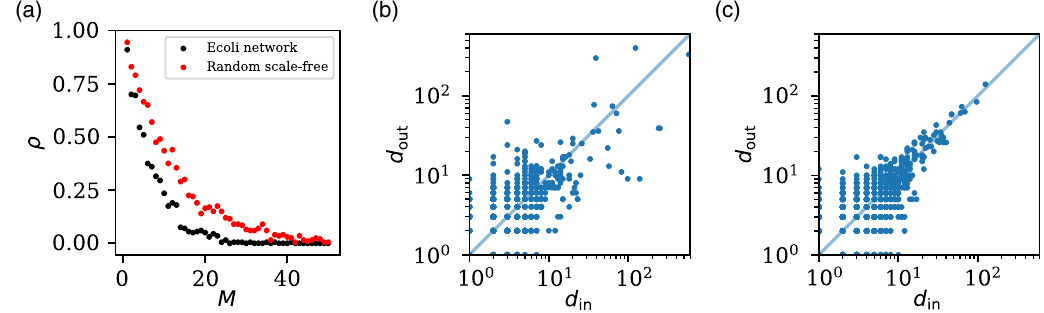
FIG. 7. Effect of the degree distribution on invertibility under the uniform random scheme. (a) The fraction of structural invertible input-output configurations for the E. coli metabolic network (black dots) is compared to an ensemble of scale-free random networks ¯ d ¼ 11 . 17 . (b),(c) The out degree versus the in degree for the with the same power law exponent γ ¼ 2 . 61 and the same average degree E. coli metabolic network (b) and a typical scale-free network (c).